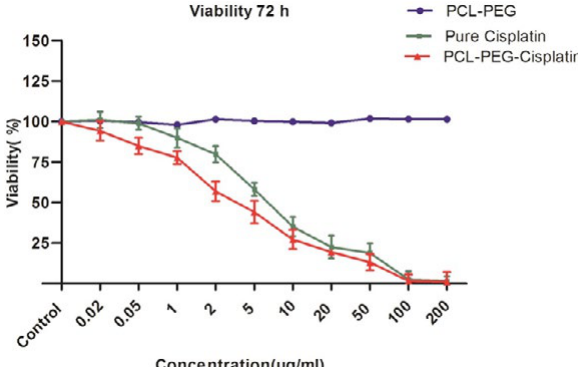
Fig. 6.c: The results of treatment with dilutions of block copolymers, pure and copolymer containing cisplatin in 72